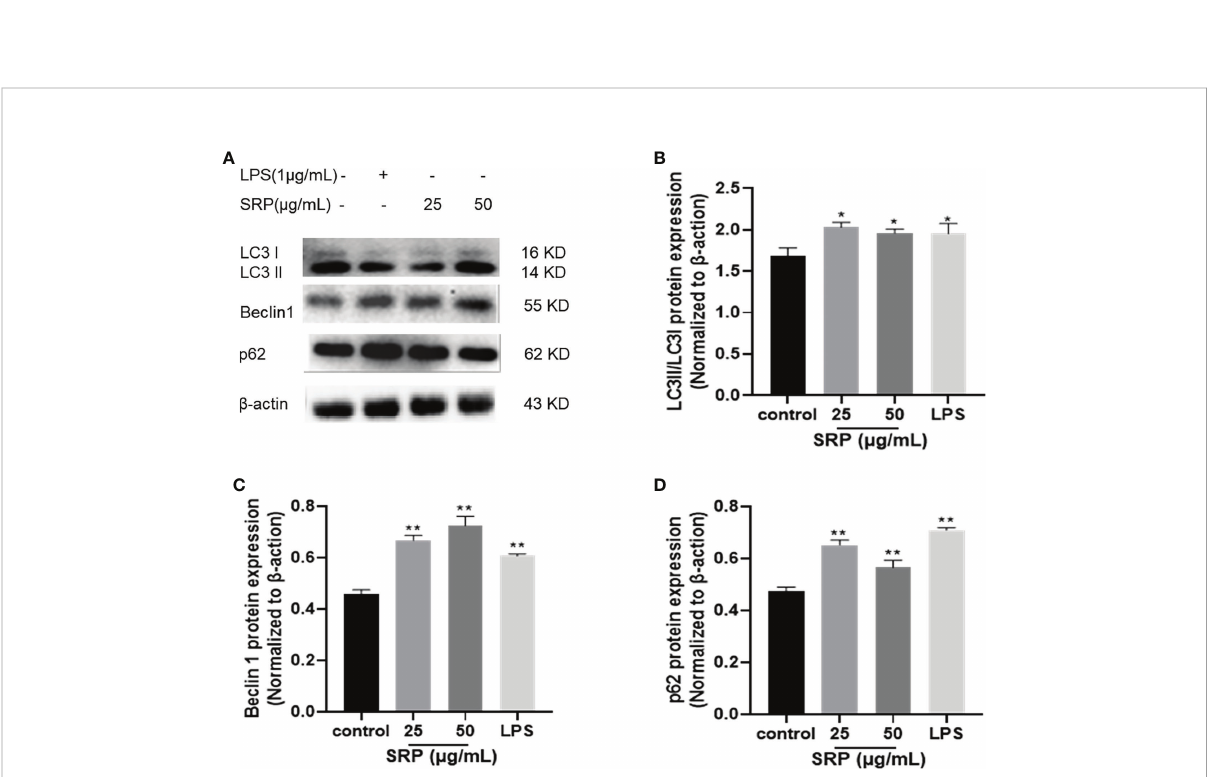
FIGURE 8 Expression of autophagic proteins. (A) Western blot analysis of protein bands; (B-D) LC3, Beclin1 and p62 protein expression. Signi fi cant differences with the control group: * p < 0.05 and ** p <